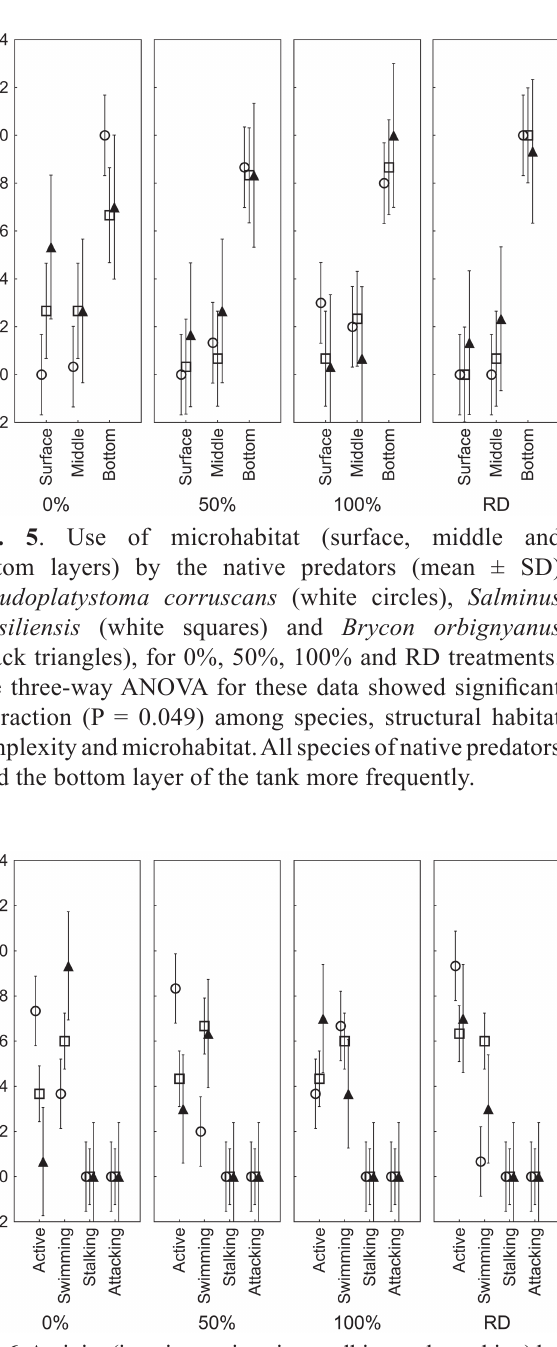
Fig. 6 . Activity (inactive, swimming, stalking and attacking) by the native predators (mean ± SD) Pseudoplatystoma corruscans (white circles), Salminus brasiliensis (white squares) and Brycon orbignyanus (black triangles), for 0%, 50%, 100% and RD treatments. The three-way ANOVA for these data suggested that the interaction among species, structural habitat complexity and activity was significant (P < 0.001). The native predators did not stalk or attack in any of the treatments.